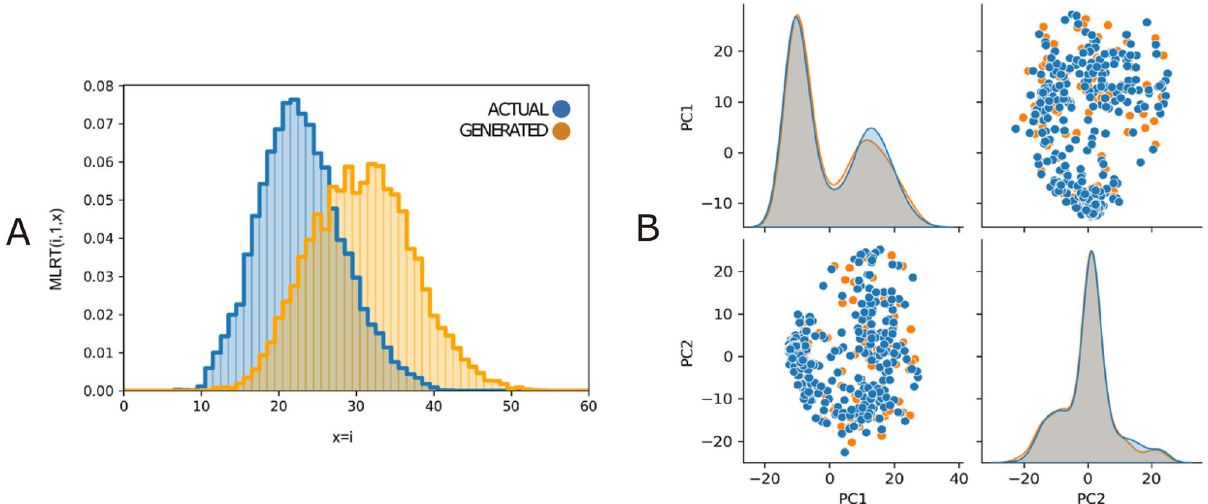
Figure 3. ( A ) GS distribution of the real (blue) and generated (orange) data set. For more information about the GS metric see section “Materials and methods”: Evaluation metrics. ( B ) PCA comparison on the full real dataset and randomly generated 1200 samples.